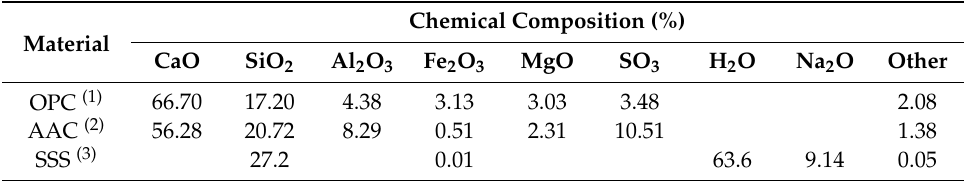
Table 1. Chemical compositions of the used materials.